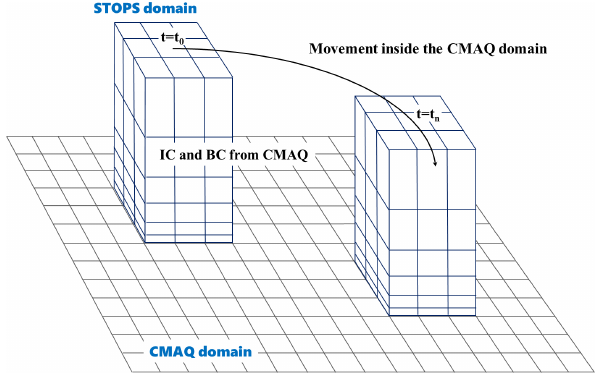
Figure 1. Conceptual diagram showing the basic structure and movement of the STOPS domain inside the CMAQ